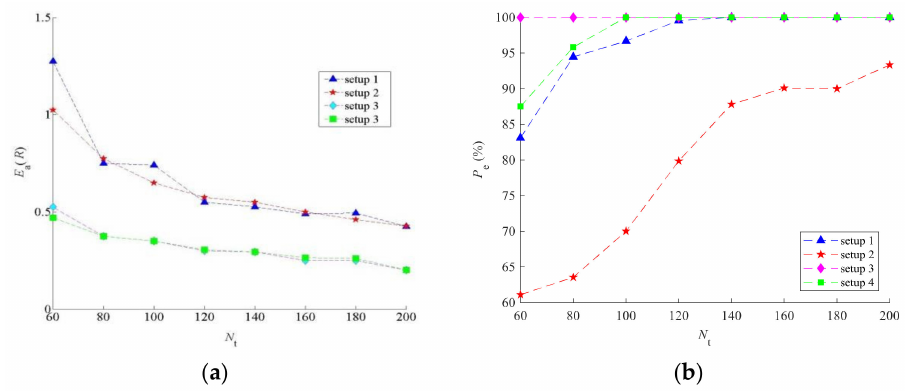
Figure 9. Effect of density of nodes on the VTL scheme ( R = 20 m, E GPS = 0, K = 6). ( a ) Average estimation error E a . ( b ) Estimation percentage P e